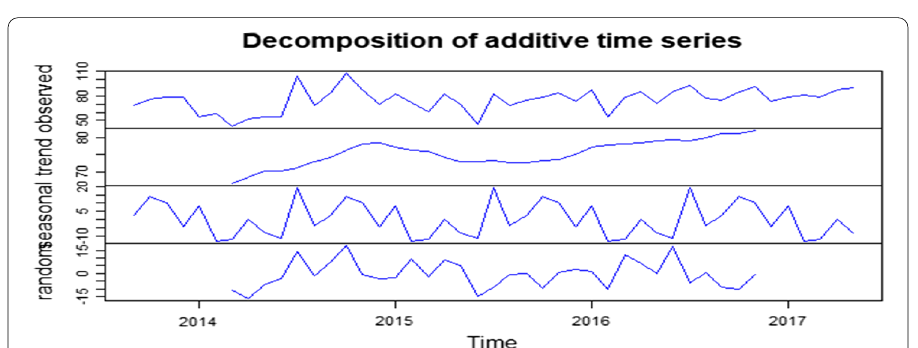
Fig.4 Time series decomposition of Total RTA